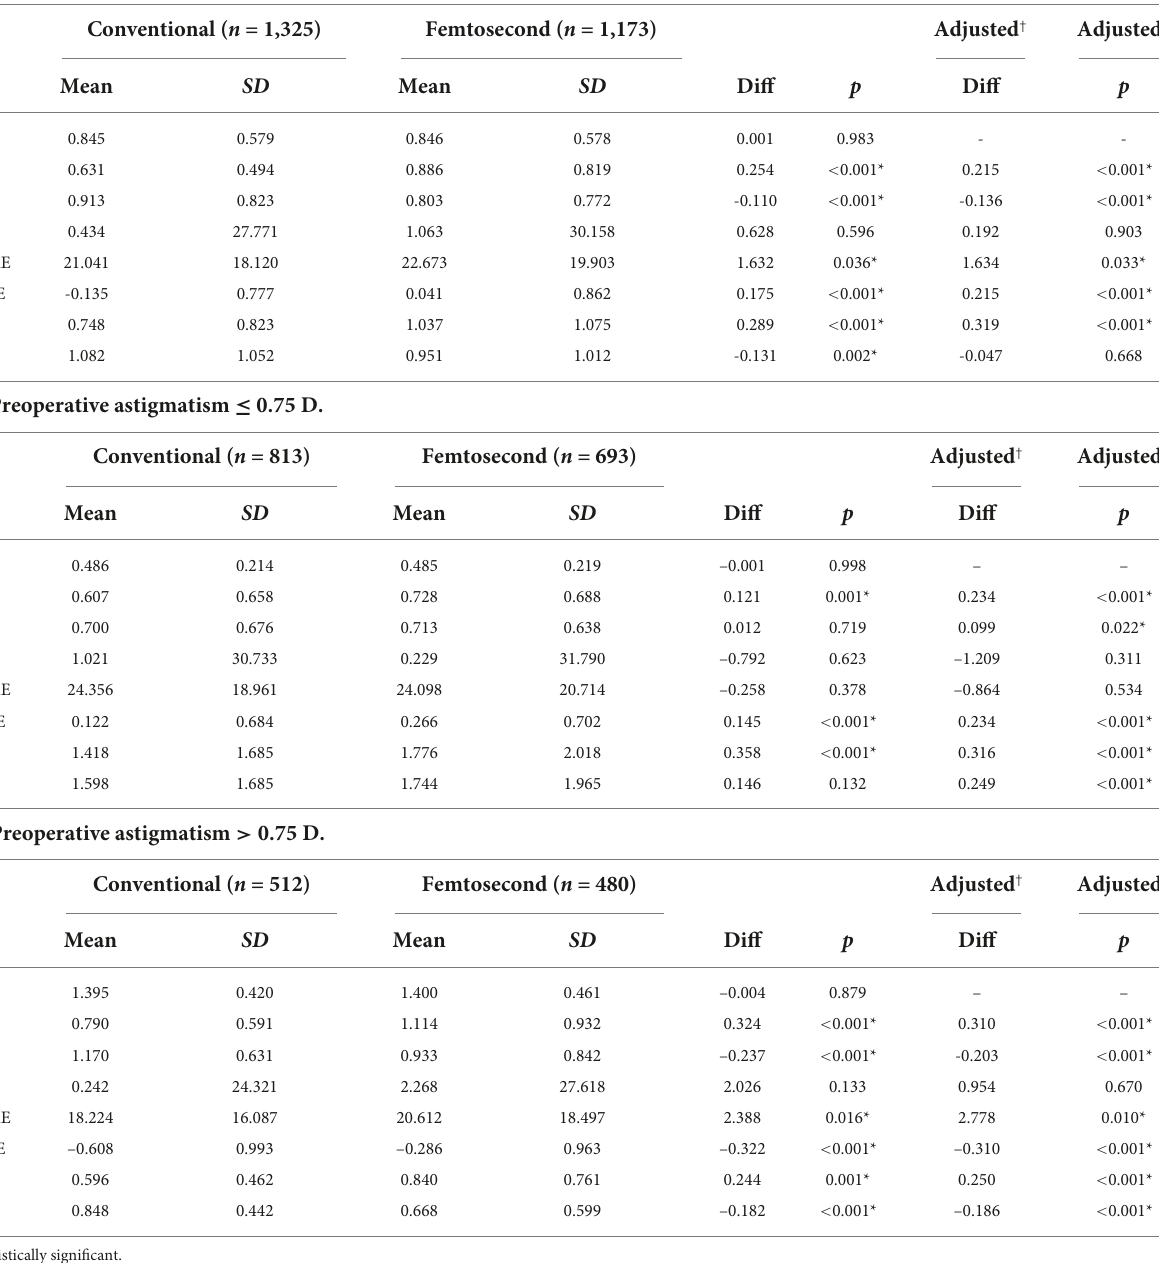
TABLE 2 Vector analysis of postoperative corneal